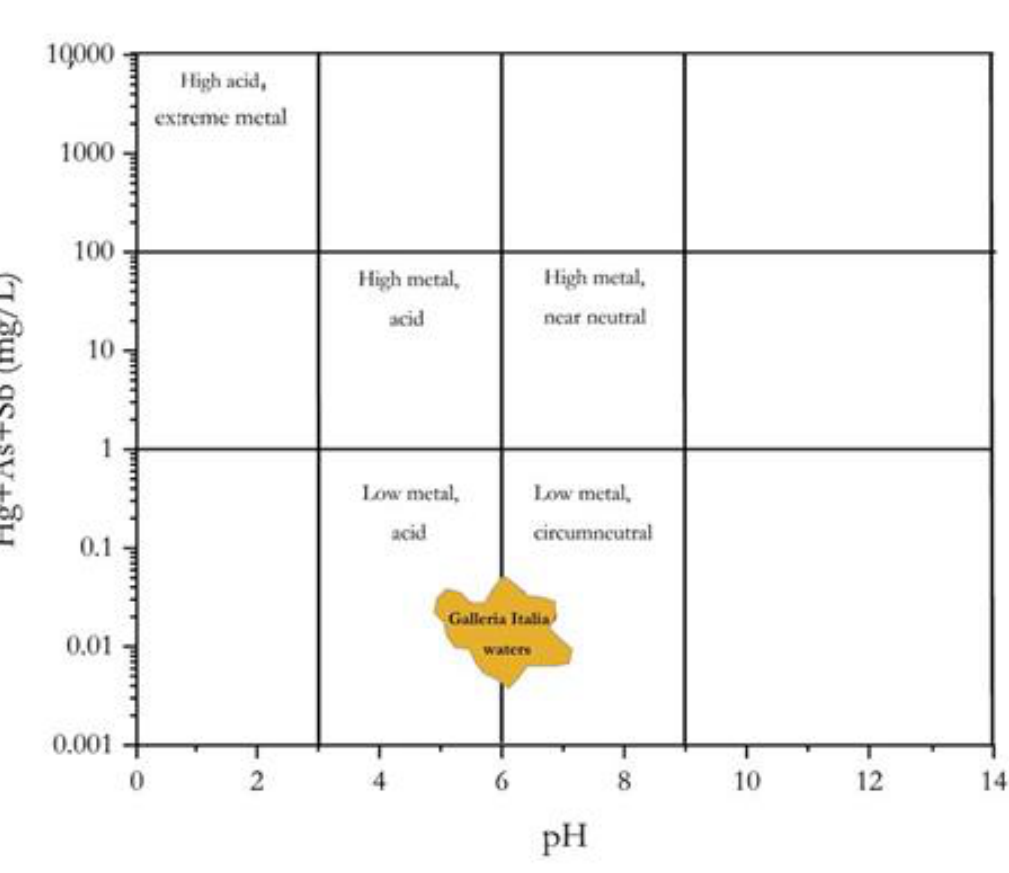
Figure 7. Hg + As + Sb (in mg L − 1 in log scale) vs. pH (after [58]) for the Galleria Italia waters.